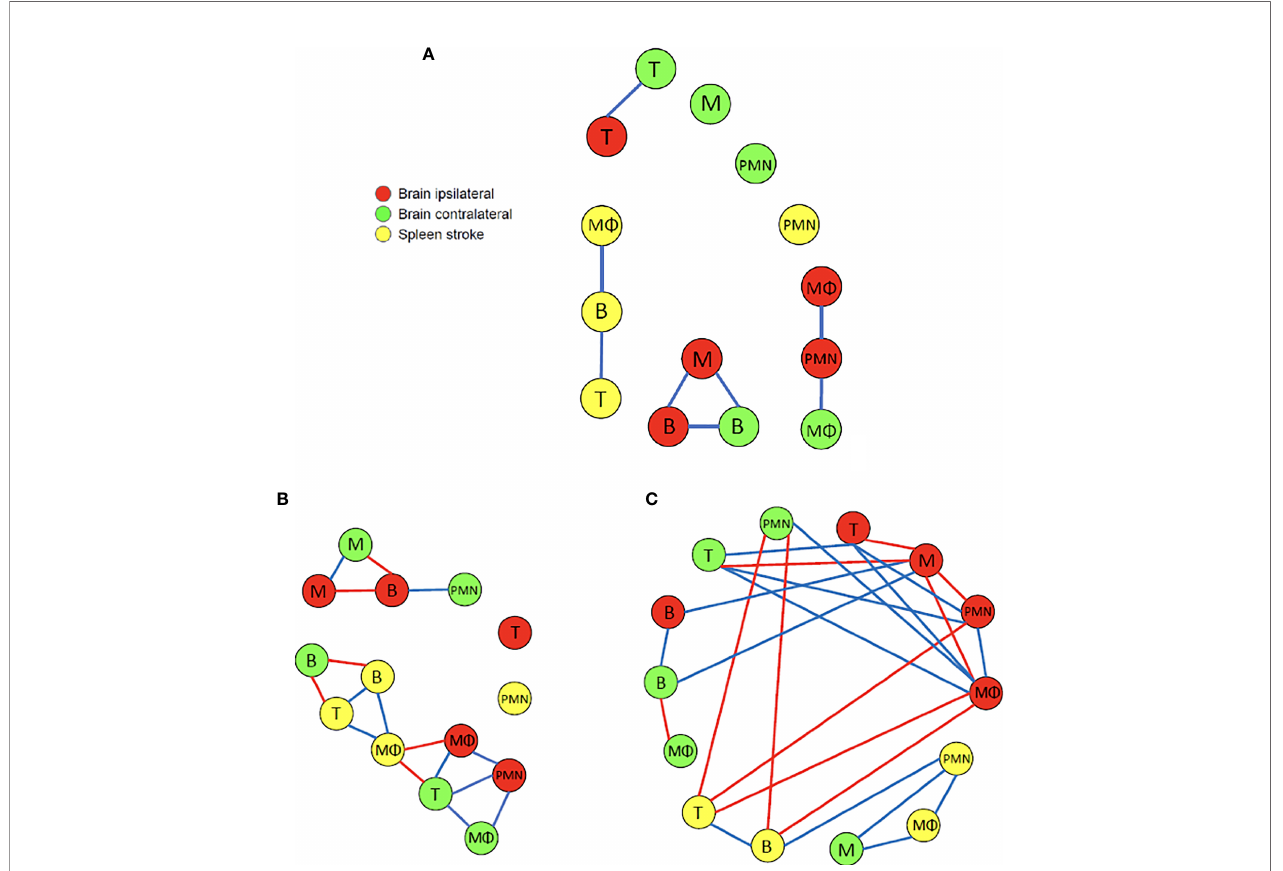
FIGURE 7 | A graphical depiction of the cell types with dynamics that are highly correlated over time following the MCAO. The blue and red edges between nodes denote cell types that share high positive or negative correlation, respectively. (A) During the interval of day 0 to day 7 post insult a Pearson correlation coef fi cient value of | r | > 0.8 was deemed high (N=5-14). Interestingly, no high negative correlations are noted, and there is no high correlation among any of the cell types in the brain with those in the spleen. (B) During the interval of day 0 to day 3 post insult a Pearson correlation coef fi cient value of | r | > 0. 8 was deemed high (N=5-14). (C) During the interval of day 4 to day 7 post insult a Pearson correlation coef fi cient value of | r | > 0.9 was deemed high